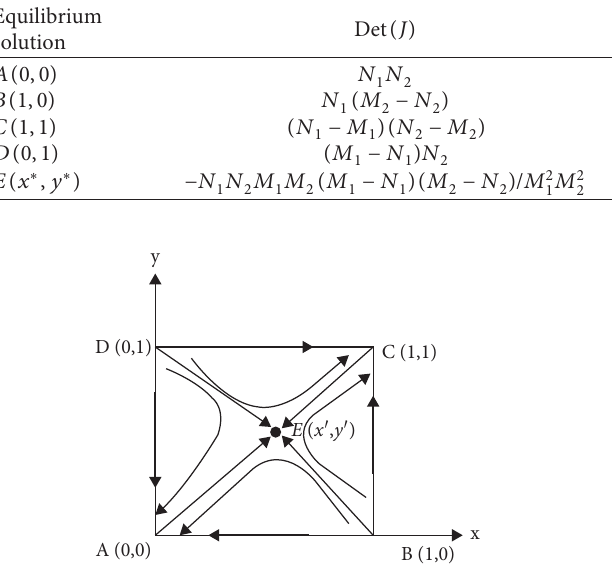
> N and M > N . 1 1 2 2